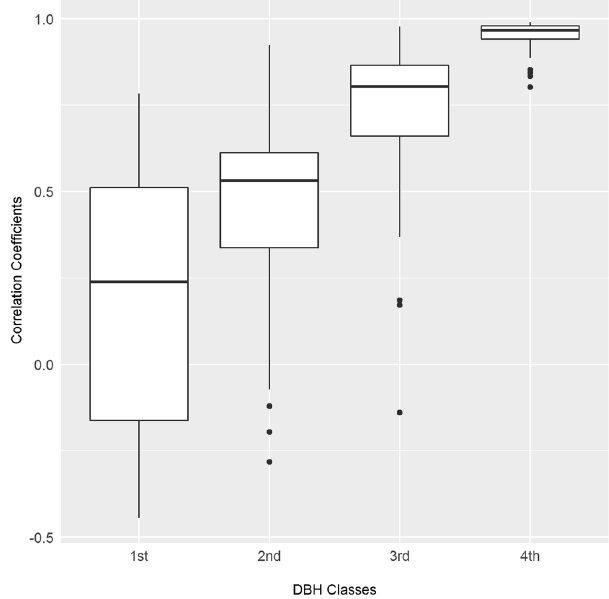
Figure 2. Correlations of plot NPP with summed NPP series for trees within four DBH class. Trees in each plots were grouped into four quartiles (4 th for the 1/4 largest trees) based on their DBH. Each box represents the variation of correlation coefficients for 36